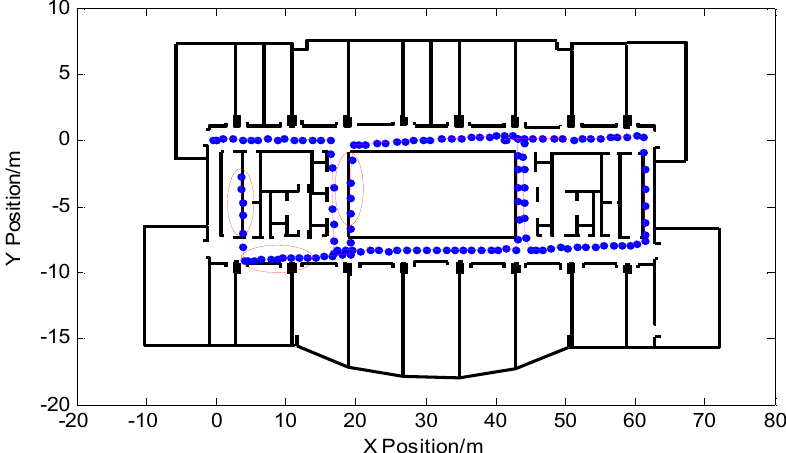
Figure 14. Correction of pedestrian trajectory based on the turn-straight-state threshold detection method.